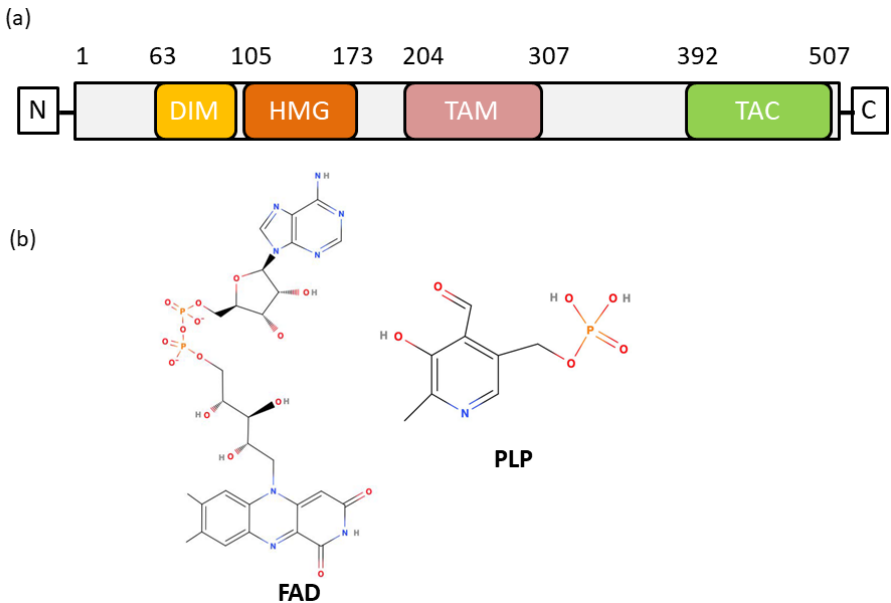
Figure 1. Structural and functional domains of the SOX9 and chemical structure of FAD and PLP . ( a ) Domain organization of the Sox9 protein. Dimerization domain (DIM) is located at N-terminus and precedes the HMG domain. The HMG domain is followed by two separate transactivation domains, TAM and TAC. ( b ) Chemical structure of FAD and PLP.